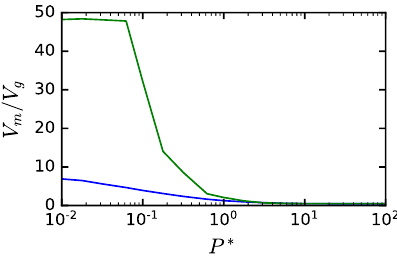
Figure 3. Volume-averaged pore volume V m , normalised by grain volume V g , versus P ⇤ in isotropic compressions of Fig. 1 (same colour code).